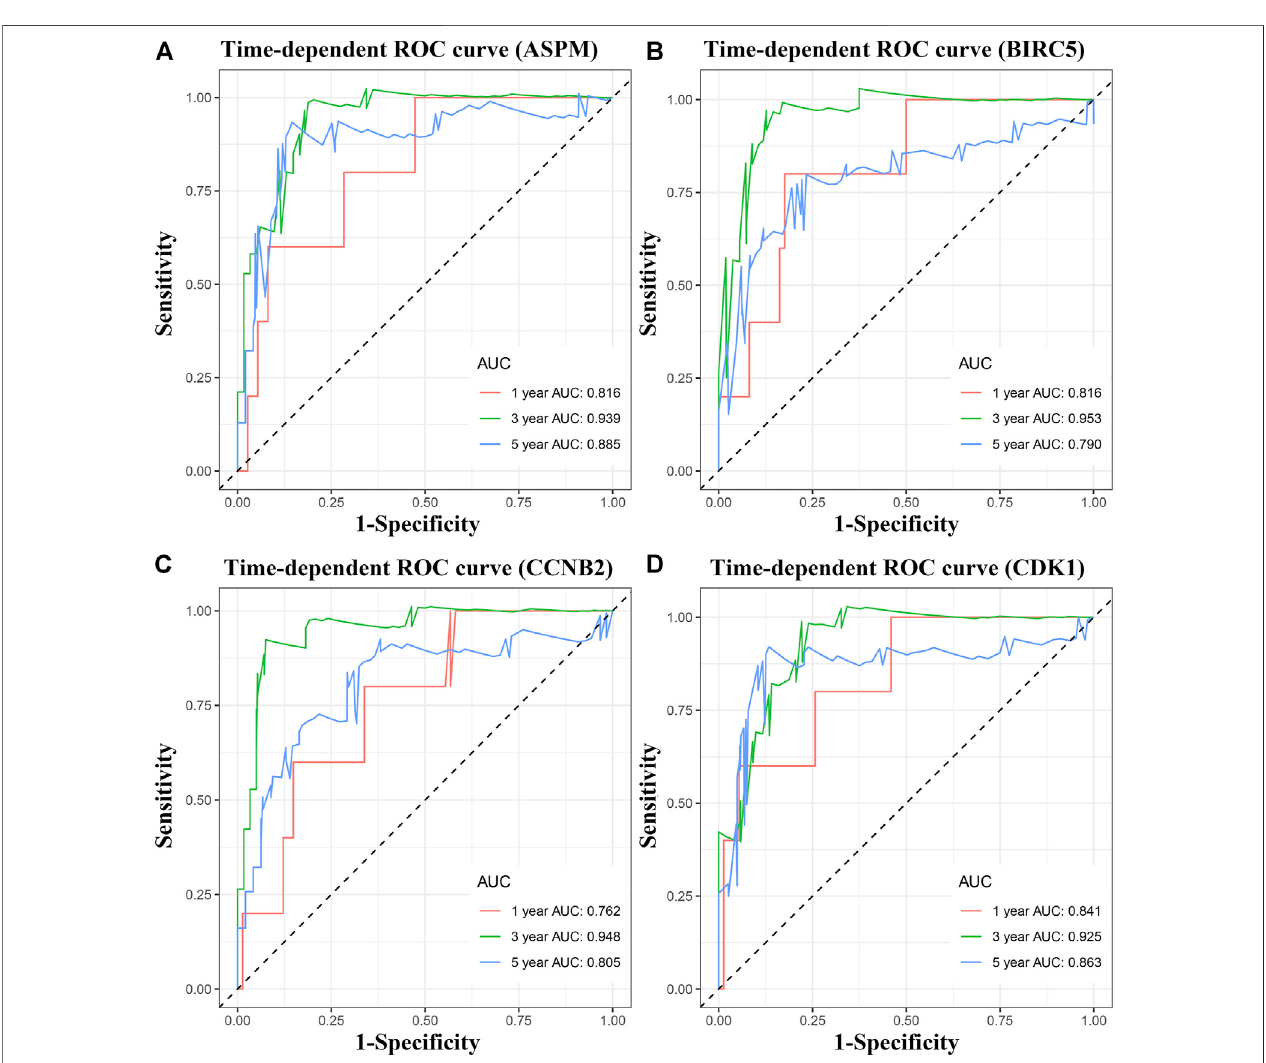
FIGURE 4 | Time dependent ROC analyses at 1, 3, and 5 years based on MPB expression. (A) ASPM, (B) BIRC5, (C) CCNB2, and (D) CDK1.